Question: Provide a publication-style caption for this figure.
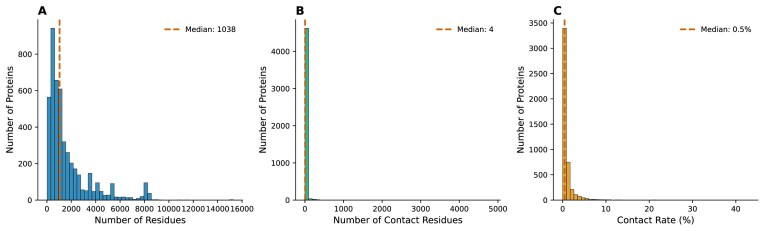
Answer: Protein-level statistics. Distribution of protein sizes and contact densities across the MPLID dataset, illustrating the diversity of membrane protein families represented.